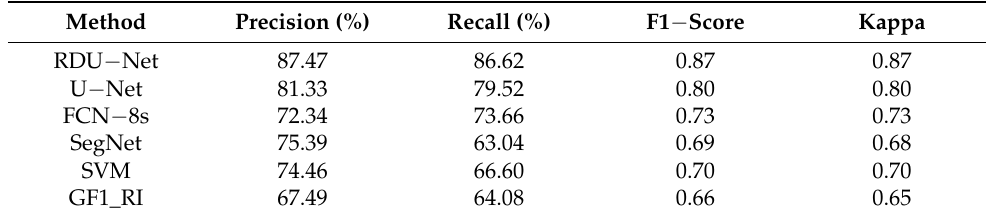
Table 3. Red tide detection accuracy of different